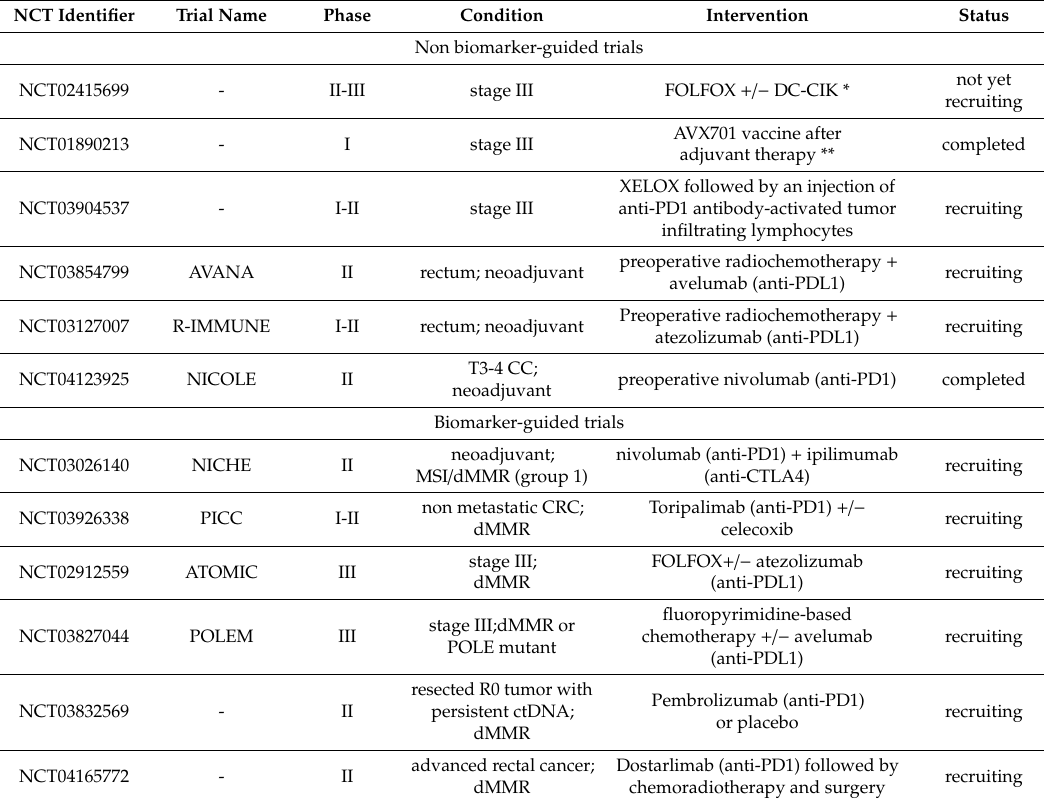
Table 1. Immunotherapy trials in adjuvant setting for CRC